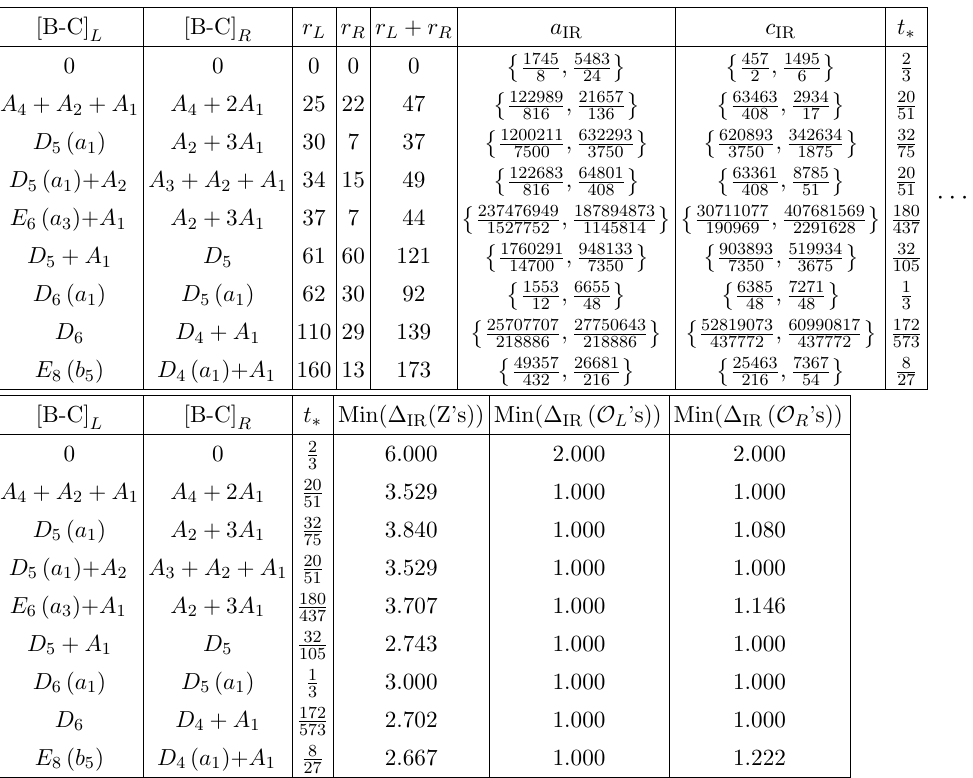
Table 23. Flipper (cid:12)eld deformations of ( E 8 , E 8 ) conformal matter, only rational values.